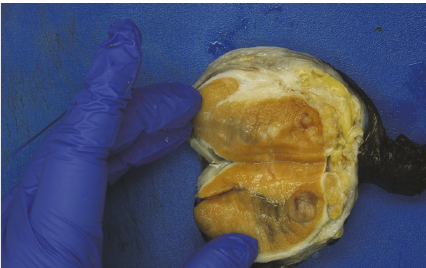
Figure 5: Gross right testis, bisected, showing nodules within the testis.